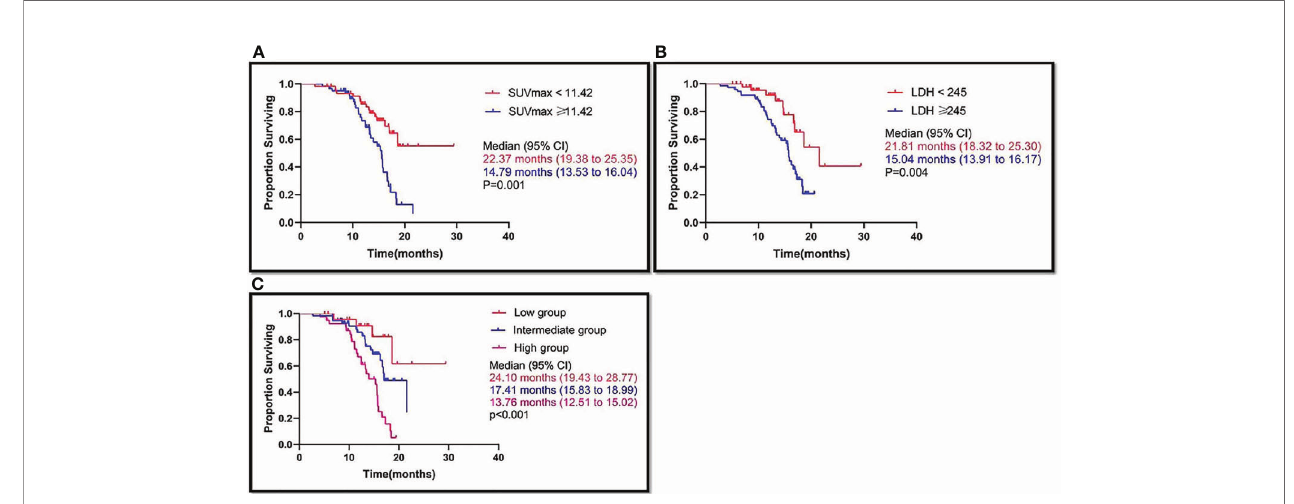
FIGURE 3 | SUVmax ≥ 11.42, LDH ≥ 245 and high group (SUVmax ≥ 11.42 and LDH ≥ 245), was associated with poor outcome. Kaplan-Meier analysis for Overall survival (OS) in the SUVmax ≥ 11.42 vs. SUVmax <11.42 (A) ; LDH ≥ 245 vs. LDH <245 (B) ; high group (SUVmax ≥ 11.42 and LDH ≥ 245) vs. intermediate group (LDH<245 or SUVmax<11.42) vs. low group (LDH<245 and SUVmax<11.42) (C) , respectively.